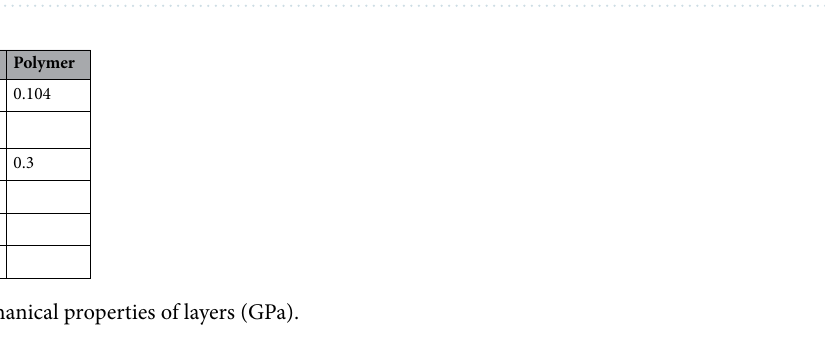
Figure 2. The schematic of the 3D printed custom-made gripping system and their assemblage with the 3D printed sandwich panel with an auxetic core.